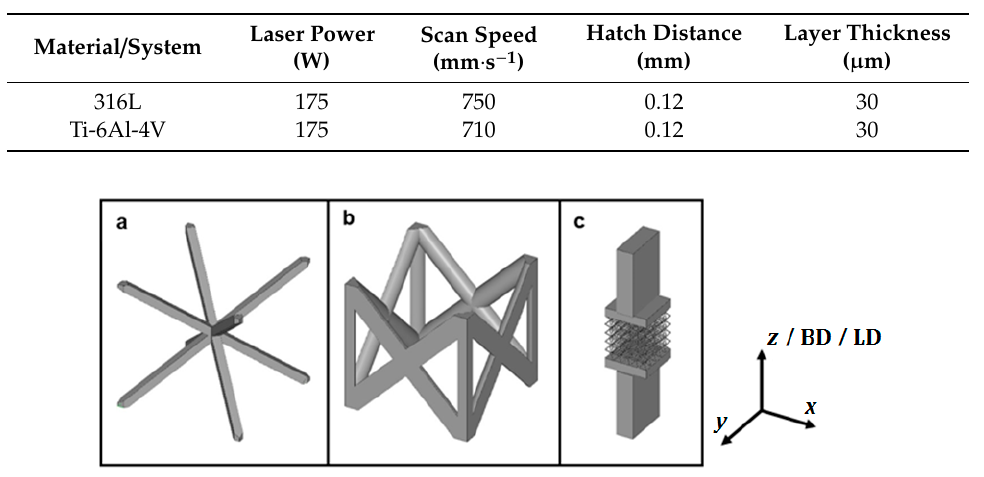
Table 3. Process parameters employed for manufacturing of the lattice structure test specimens.